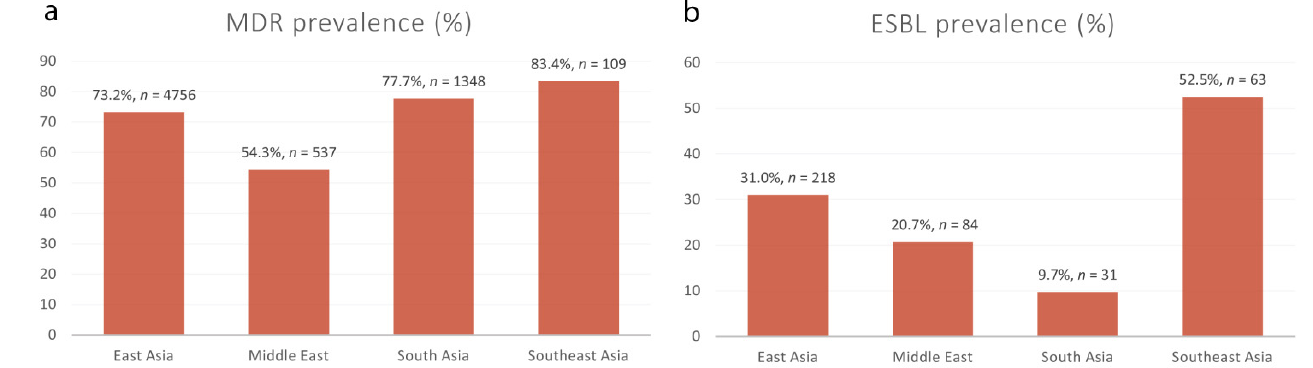
Figure 7. The prevalence rates of MDR and ESBL-producing Shigella isolates grouped according to different Asian regions. ( a ) The prevalence rates of MDR Shigella spp. in East Asia (73.2%), the Middle East (54.3%), South Asia (77.7%) and Southeast Asia (83.4%). ( b ) The prevalence rates of ESBL-producing Shigella spp. in East Asia (31.0%), the Middle East (20.7%), South Asia (9.7%) and Southeast Asia (52.5%).